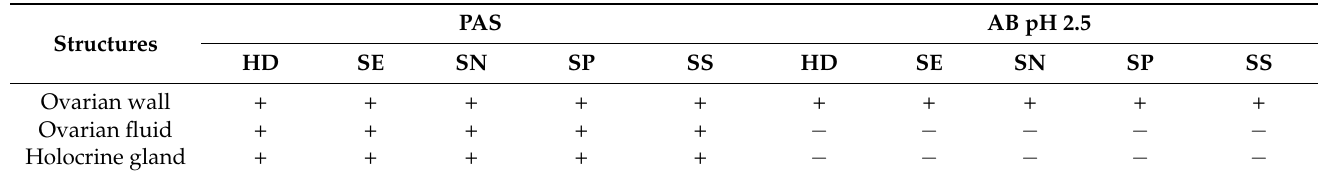
Table 2. Histochemical properties of the internal epithelium of the ovarian wall, ovarian fluid, and holocrine gland in the rachis in Helicolenus dactylopterus (HD), Scorpaena elongata (SE); Scorpaena notata (SN), Scorpaena porcus (SP) and Scorpaena scrofa (SS). PAS, periodic acid–Schiff; AB, Alcian blue; +, presence; − ,